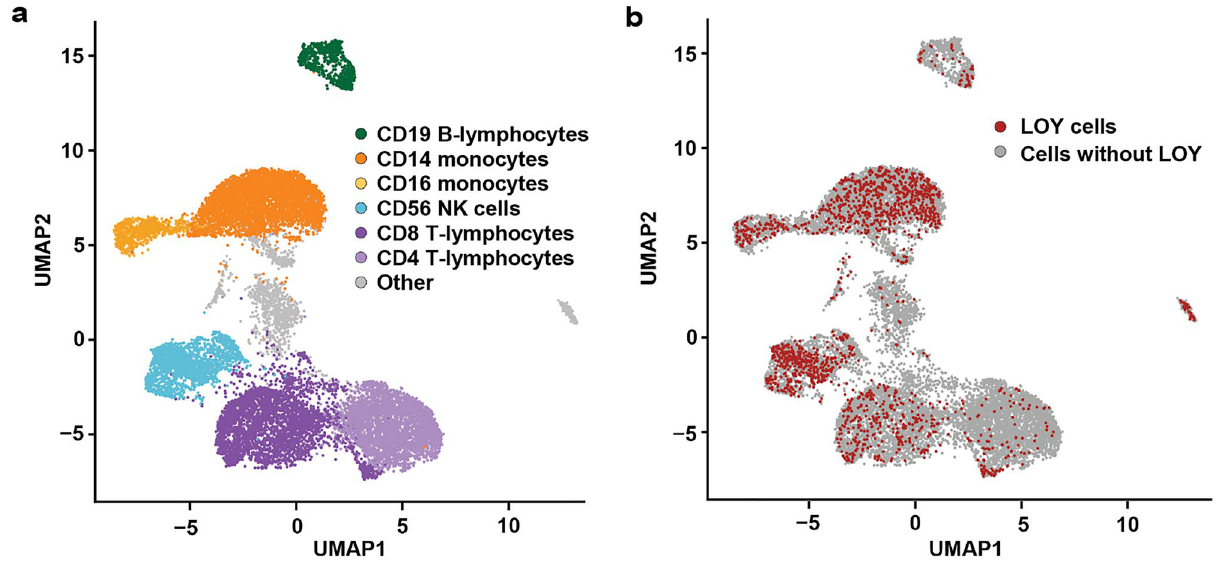
Figure 1. Occurrence of chromosome Y loss in different types of leukocytes visualized using UMAP based on CITE-seq single cell mRNA sequencing readout. Panel ( a ) displays six types of leukocytes labeled by color and named by the cell surface protein marker targeted in CITE-seq protocol. Grey color denotes single cells of other types of leukocytes, not targeted at the protein level by the applied assay. Panel ( b ) illustrates the distribution of single cells classified as LOY cells (red) as well as normal cells (grey). The percentage of LOY within each cell type were: 5.6% in CD19 B-lymphocytes, 15.2% in CD14 monocytes, 15.0% in CD16 monocytes, 20.9% in CD56 NK cells, 8.6% in CD8 T-lymphocytes and 2.4% in CD4